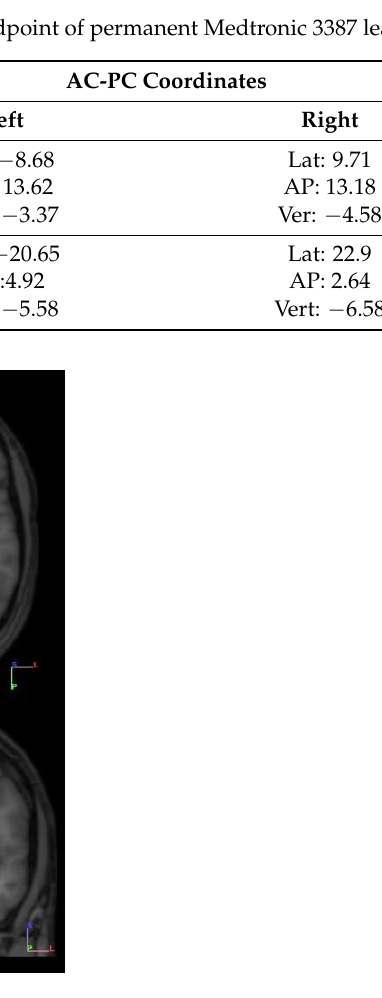
Figure 2. Axial ( A , B ) and coronal ( C , D ) views of the postoperative CT overlaid on the preoperative MRI, showing the lead locations for the Medtronic 3387 leads. MRI, showing the lead locations for the Medtronic 3387 Table 2. Target coordinates relative to AC-PC midpoint of permanent Medtronic 3387 leads.